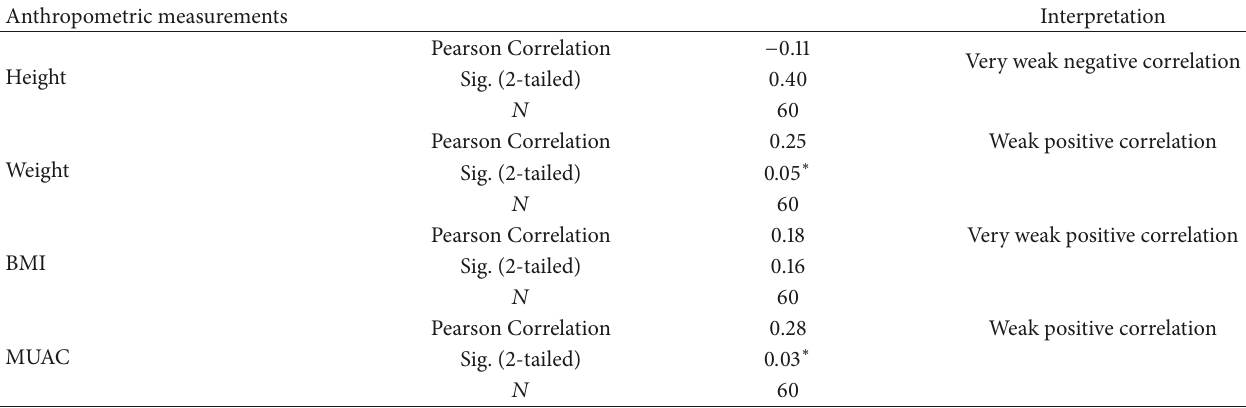
Table 8: Correlation of anthropometric measurements with psychomotor